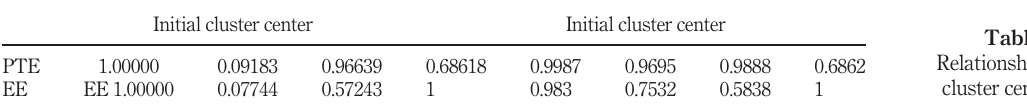
Table 6. Relationship